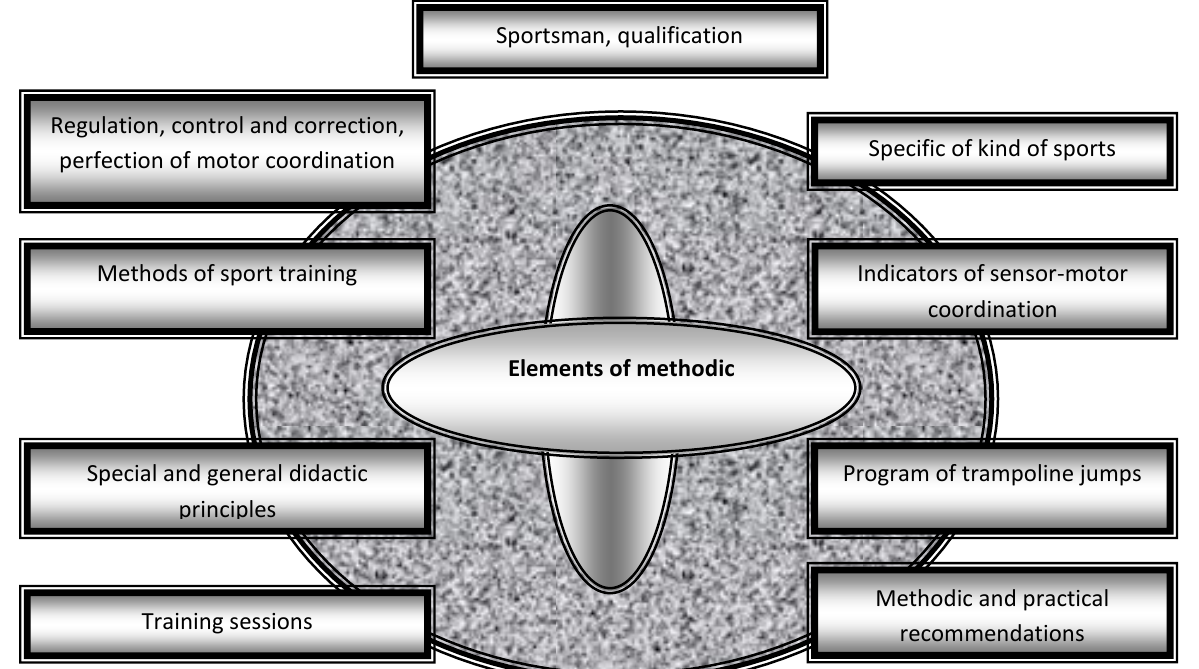
Fig.1. Elements of sportsmen’s coordination training methodic with application of trampoline